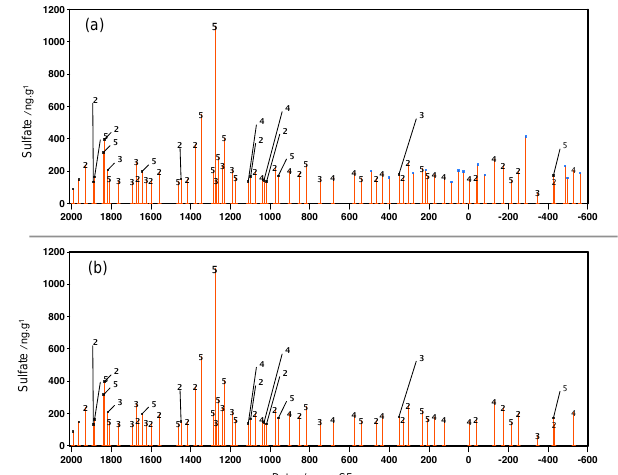
Figure 4. Panel (a) : composite sulfate peak profile deduced from our statistical analysis of the five cores using our detection peak and synchronization algorithms (see text). The numbers indicate the number of time a common peak is found in the cores. Unnumbered peaks: peaks found only in single core. Panel (b) : same as (a) with- out the single detected peaks. All the remaining peaks are consid- ered to be volcanic eruptions. See Table 2 for details.